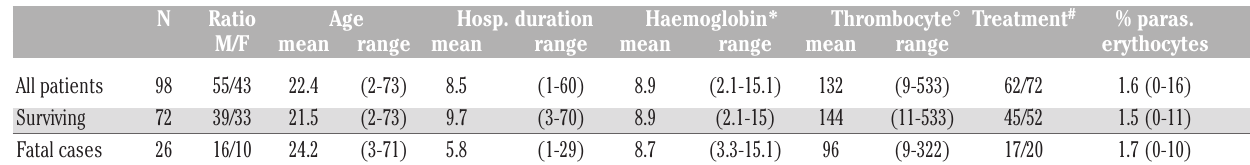
Table 1. Description and characteristics of the patients with confirmed cerebral malaria.